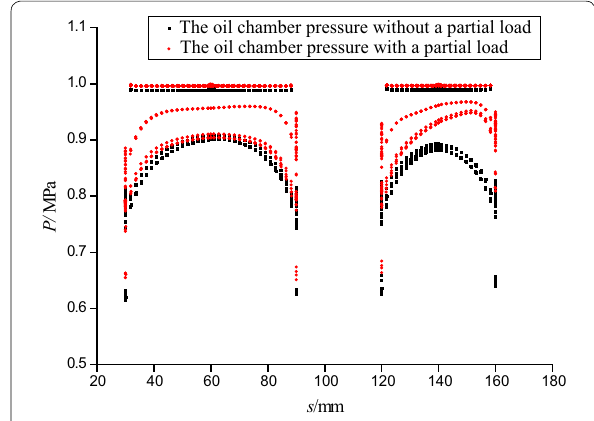
Figure 16 Oil chamber inner-wall position-pressure map